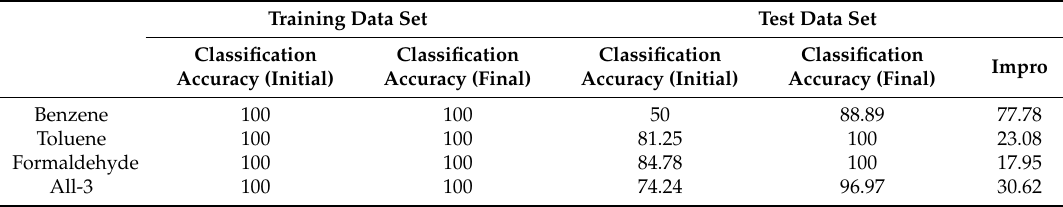
Table 8. Classification accuracy of M-training with 50%-unlabeled rate